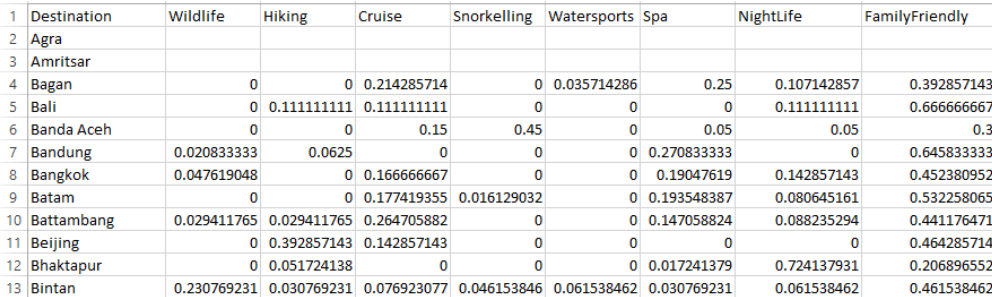
Figure 11. A sample screenshot of functions created and count of keywords extracted.